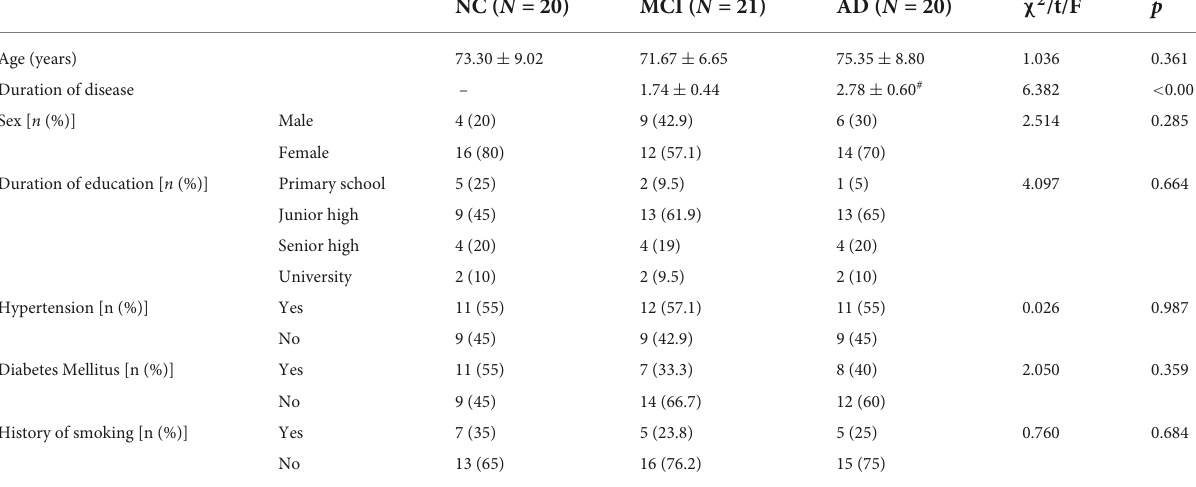
TABLE 3 General characteristics.